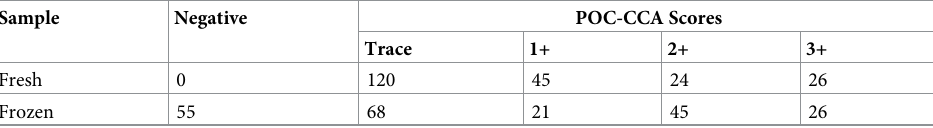
Table 4. Results of POC-CCA generated by visual scoring system on frozen and fresh urine samples.